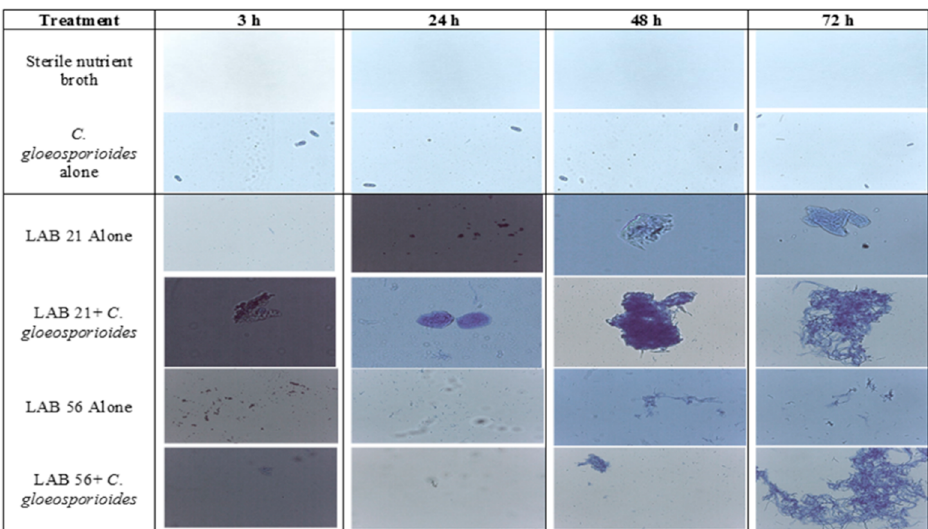
Figure 5. Effects of the incubation time on biofilm formation by LAB strains against C. gloeosporioides .